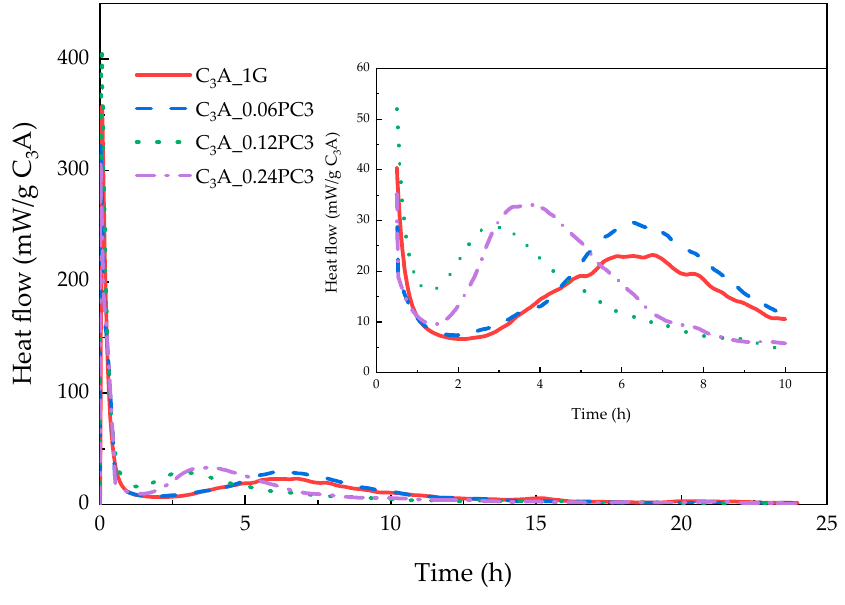
Figure 8. Heat evolution curves of C 3 A-gypsum with different concentrations of PC3 solution during the 24-h hydration.